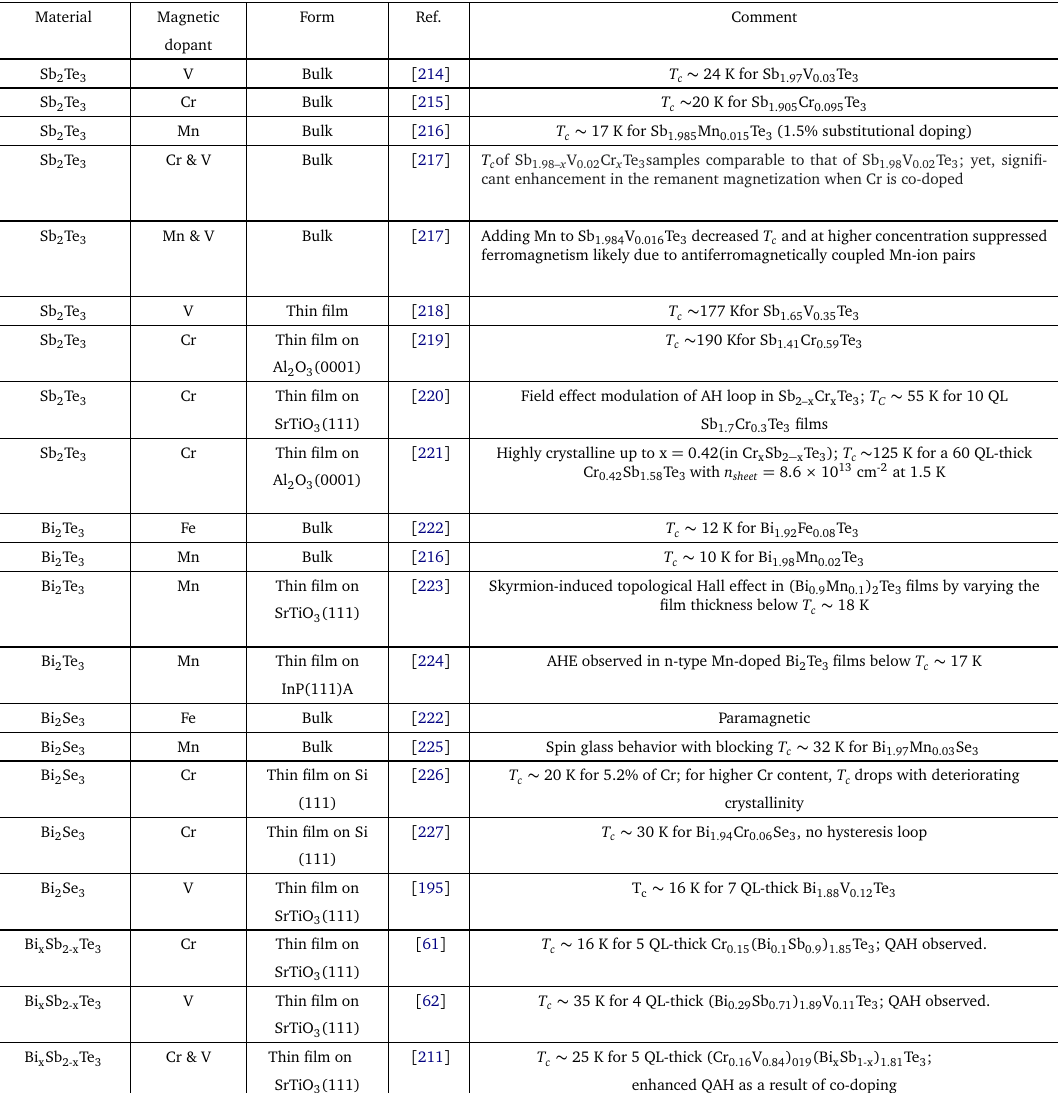
Table 2: Key properties of magnetically-doped TI thin films or single